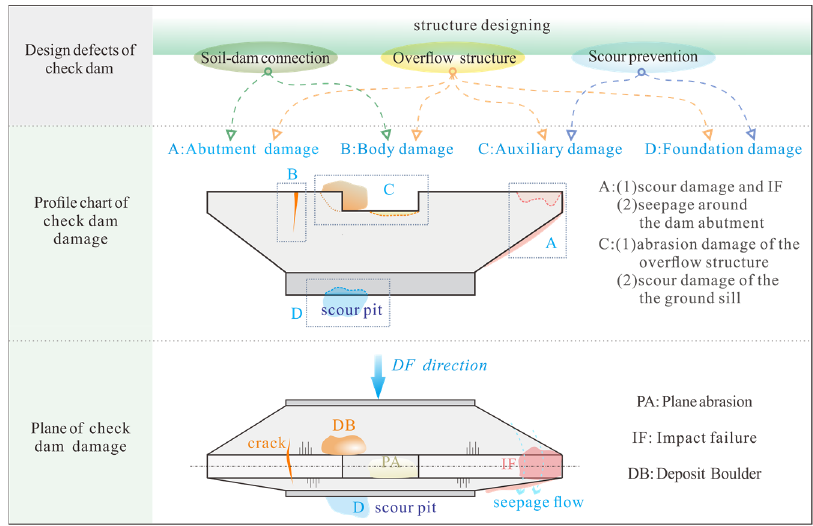
Figure 13. The damage models of a check dam under glacial debris flow.